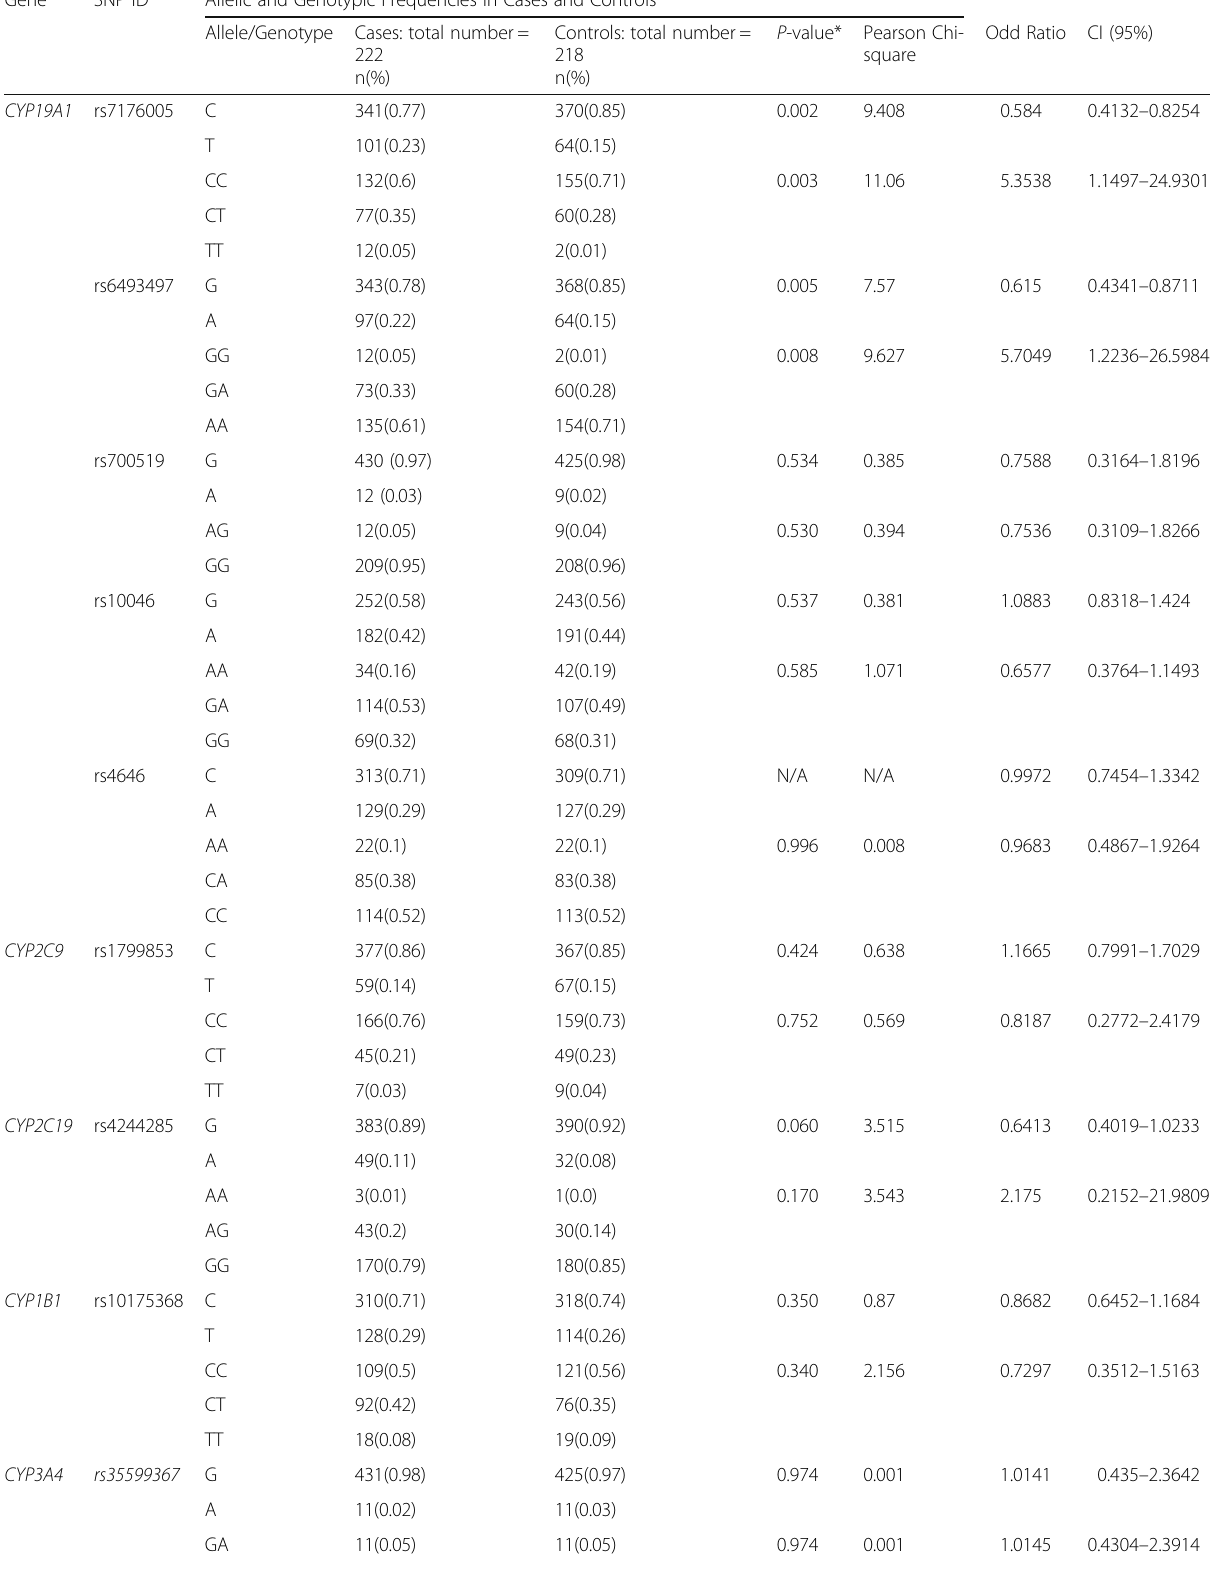
Table 3 Association of the investigated CYP450 candidate gene polymorphisms and breast cancer (BC)